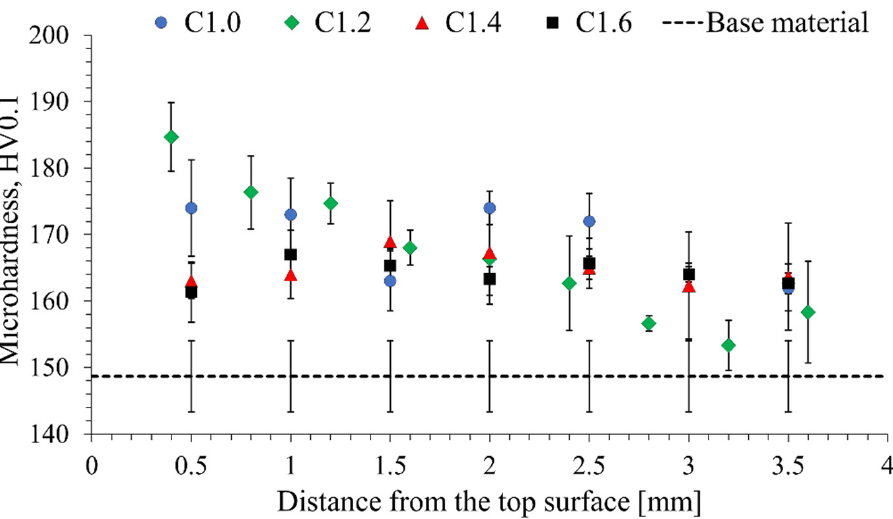
Figure 4. Distribution of microhardness in the samples rolled under cryogenic conditions.